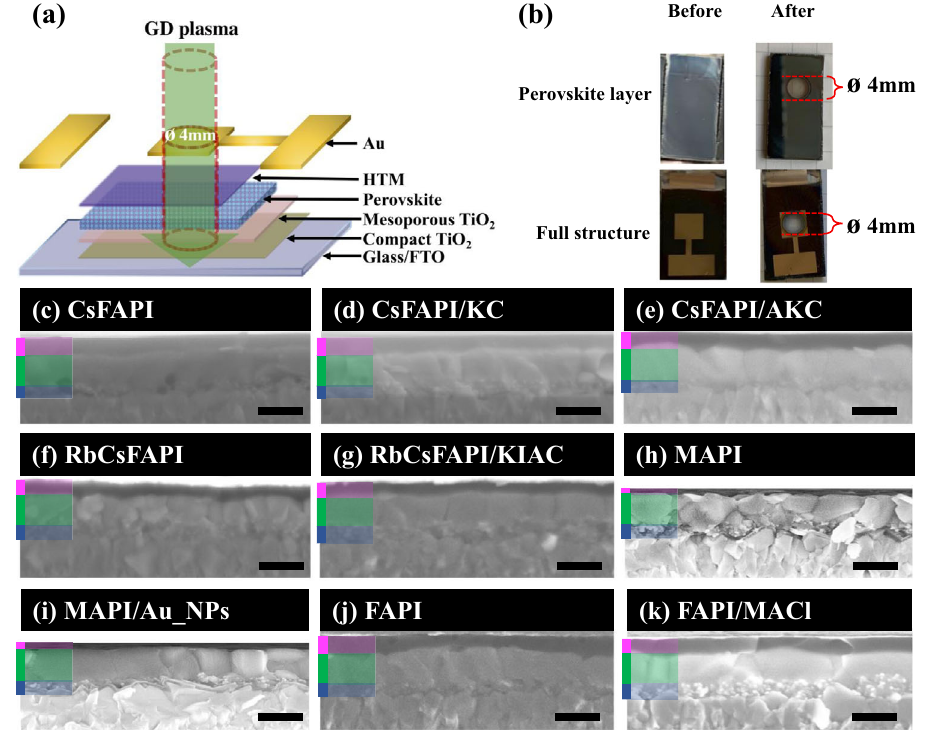
Fig.1|Cross-sectionalinvestigationofthelayerstacks.a Investigatedsolarcells architecture withthe scaleof the GD plasmabeampassing throughthe perovskite solar cell(the detection diameter is 4mm, HTM isthe holetransporting material). b Perovskite fi lmand fullstructurebeforeand after theirinvestigation by GD-OES. c – k Cross-sectional SEM views of solar cells based on c pristine CsFAPI, d CsFAPI